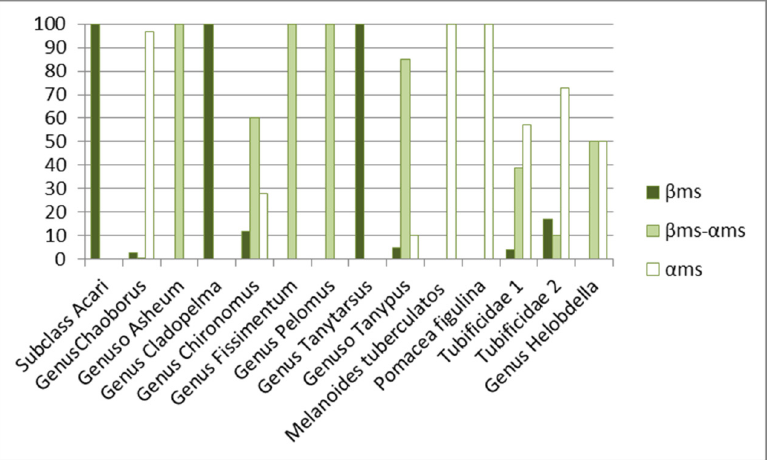
Figure 3. Frequency of occurrence of identified organisms of benthic macroinvertebrates according to saprobiotic levels for spring/summer station.